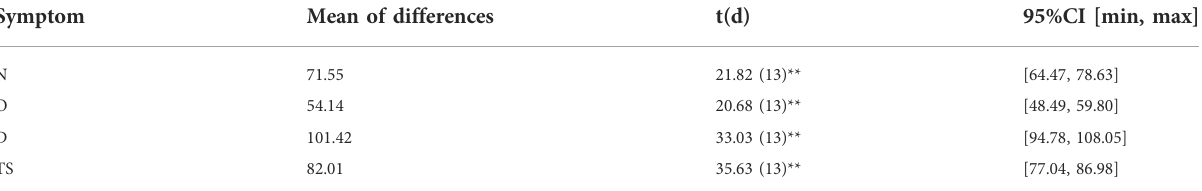
TABLE 1 t -test results for Computation of Nausea (N), Oculomotor Disturbance (O), Disorientation (D), and Total Simulator Sickness (TS) with 95% con fi dence intervals. Symptom